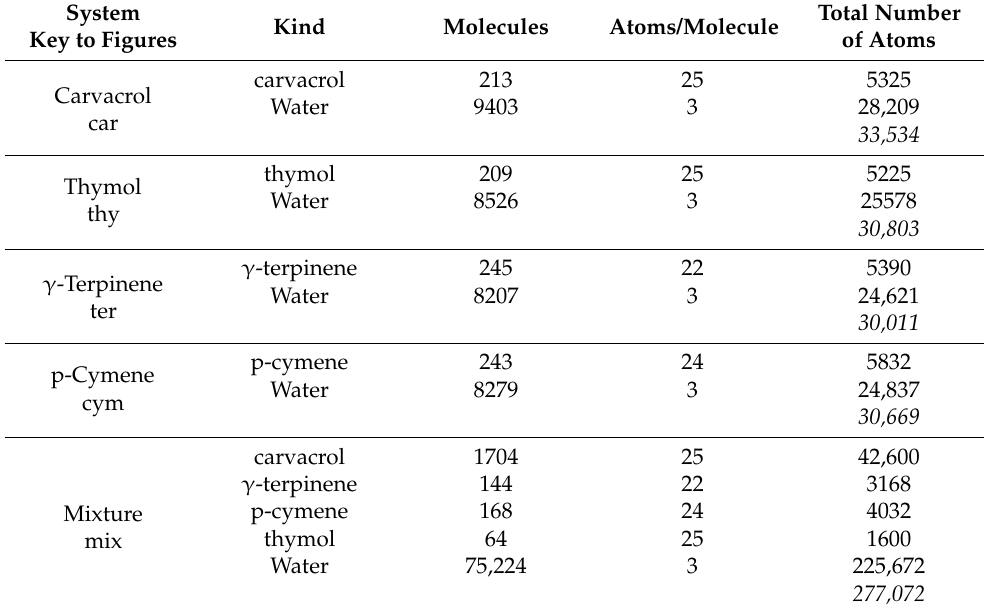
Table 1. Size and composition of terpenoid–polymer aquatic solutions. The numbers of the rightmost column shown in italics, denote the total number of atoms in each